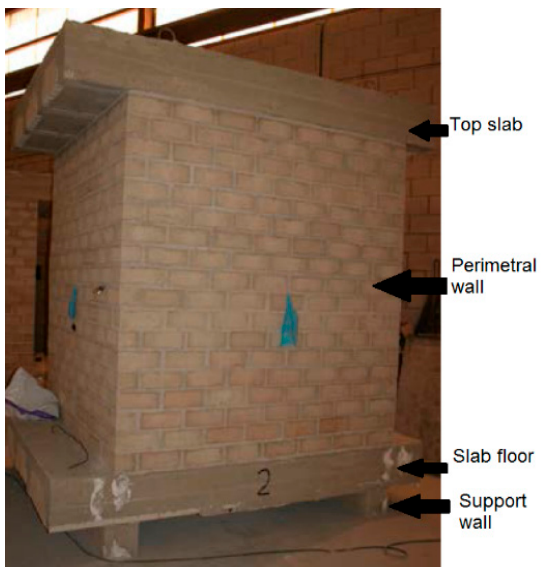
Figure 5. Geometry of the cells. Table 2. Composition of the building elements.